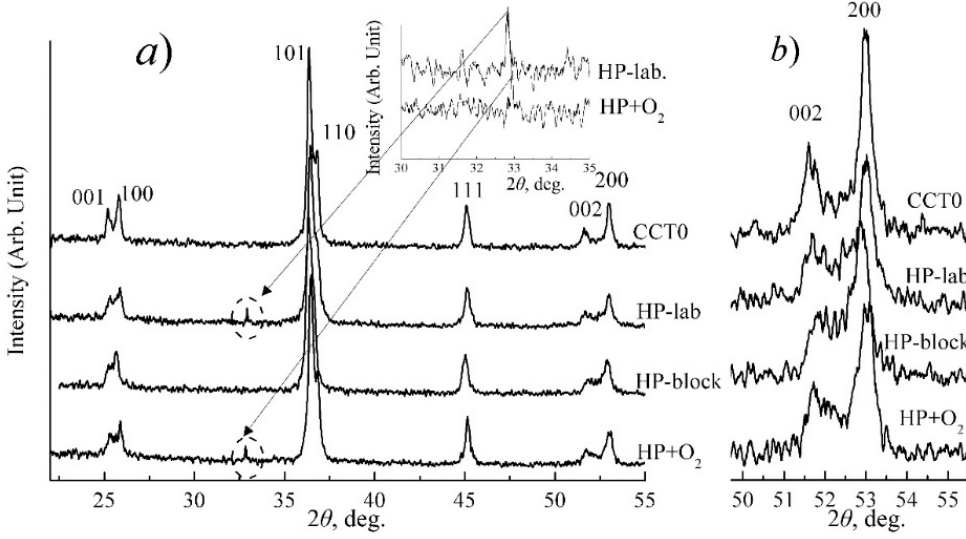
Figure 1. ( a ) X-ray patterns of PCR-13 material manufactured by different methods; and ( b ) X-ray fragments comprising lines (200) c .